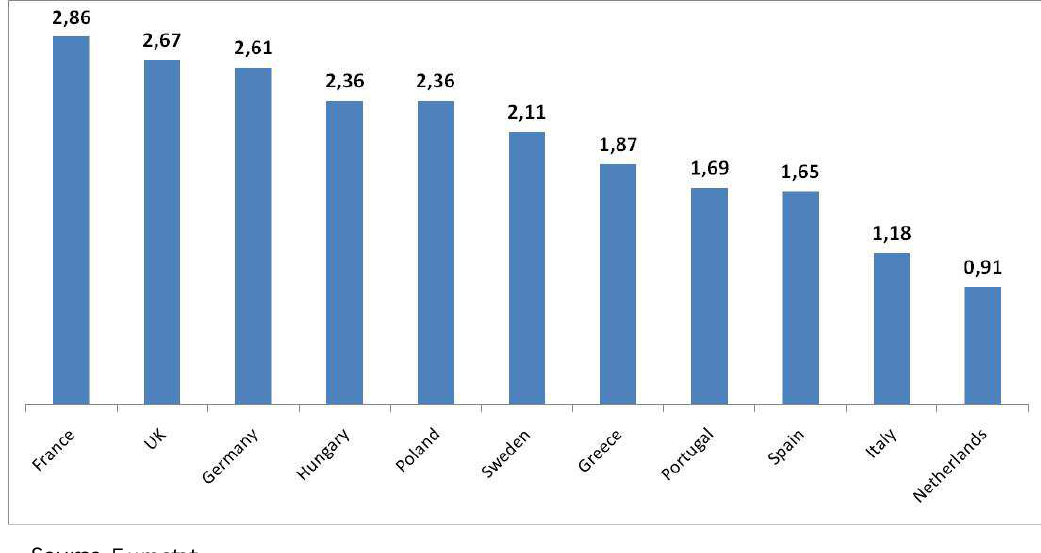
Graph 5: Concentration (Ratio between Standard Deviation of Workers amongst Areas and Standard Deviation of Population), By country, Per cent,